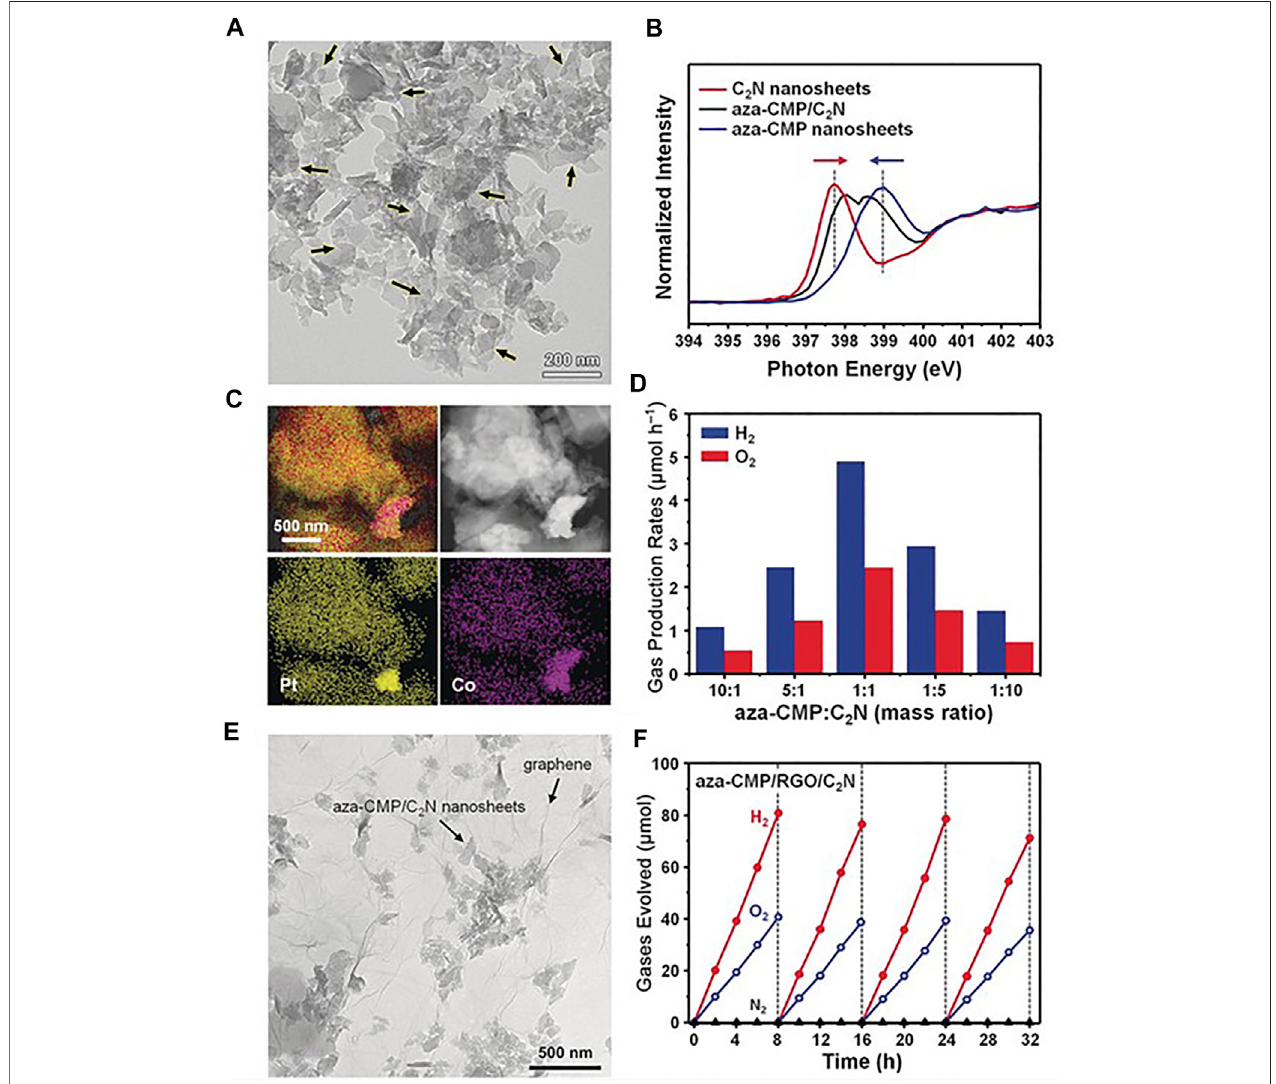
FIGURE 5 | (A) TEM image of aza-CMP/C 2 N heterostructures. Arrows indicate overlapped interfaces. (B) The N K-edge XANES spectra of aza-CMP, C 2 N, and aza-CMP/C 2 N. (C) HAADF-STEM images and elemental mapping of heterostructures formed by Pt-labeled C 2 N and Co-labeled aza-CMP. (D) The overall water- splitting performance of aza-CMP/C 2 N heterostructures with different compositions. (E) Transmission electron microscope (TEM) image of the aza-CMP/RGO/C 2 N photocatalyst. (F) Typical time course of H 2 and O 2 production using the aza-CMP/RGO/C 2 N photocatalyst under visible light irradiation. Reproduced with permission from Wang L. et al. (2018).